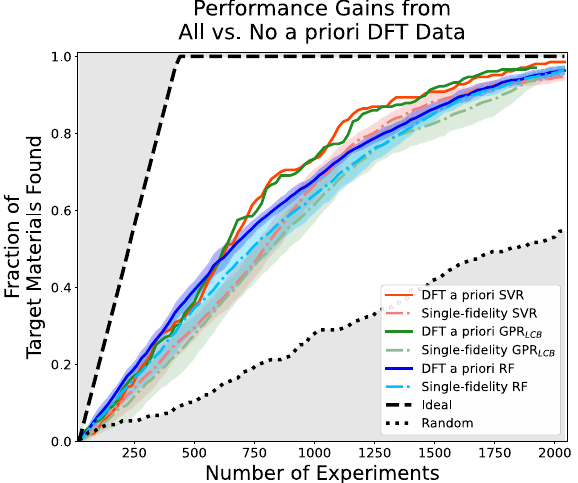
Figure 5. Simulated performance of various campaigns with and without supplying the lower fidelity (DFT) data in the seed. The x-axis corresponds to the high-fidelity (experiments) acquisition budget. The y-axis corresponds to the fraction of ideal materials discovered from the search space. SVR, RF, and GPR LCB correspond to agents using support vector regression, random forests, and Gaussian process regression lower confidence bound, respectively. The shaded colored regions are the standard deviation of materials found for campaigns with multiple trials. The random acquisition and ideal acquisition baselines are also labeled in the figure, representing the lower and upper bounds of agent performance.